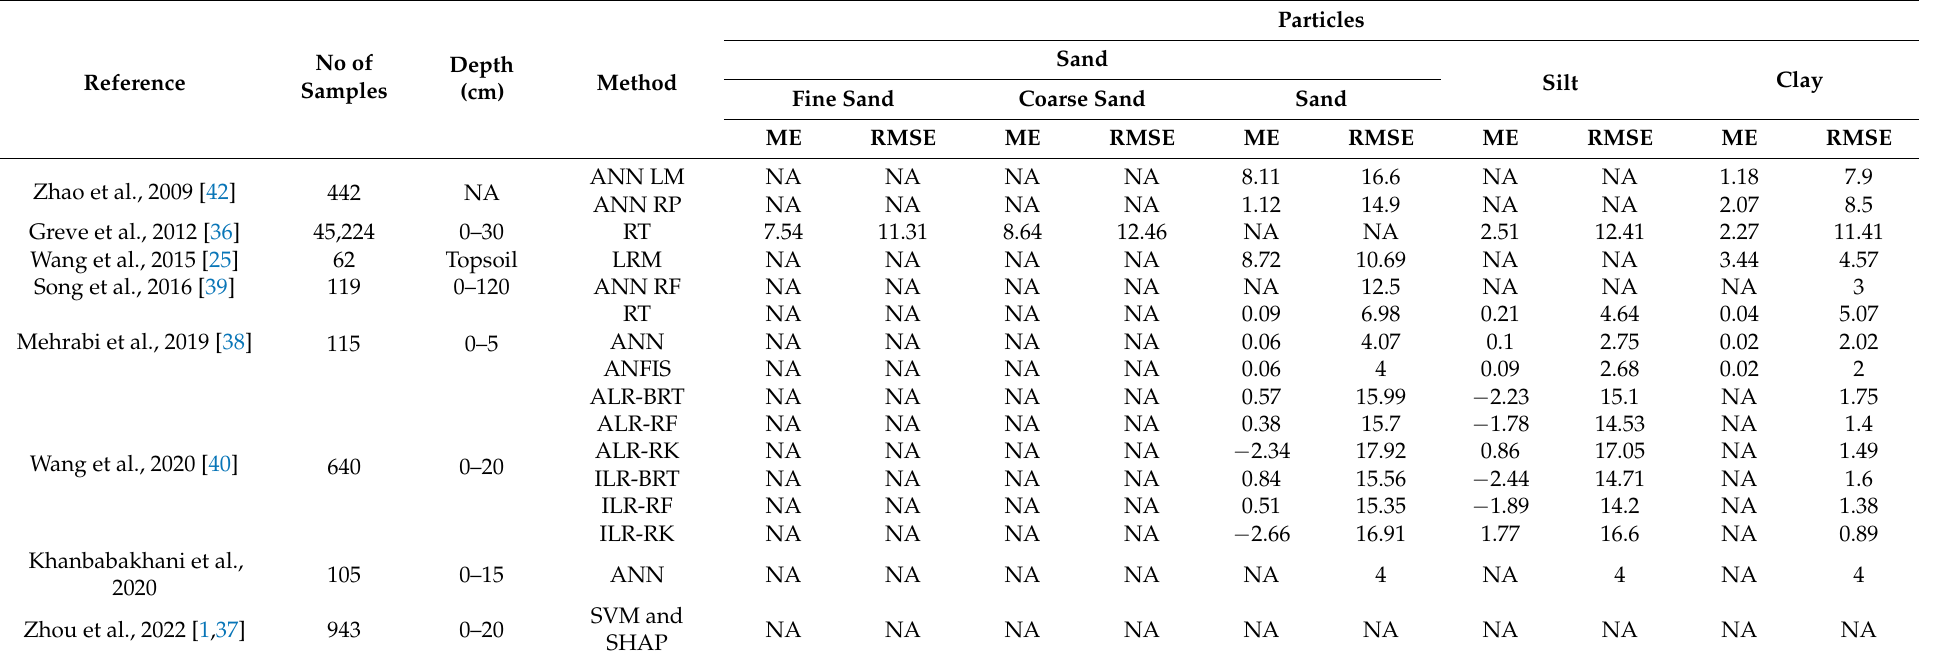
Table 6. Overview of selected research findings on STFs large-scale